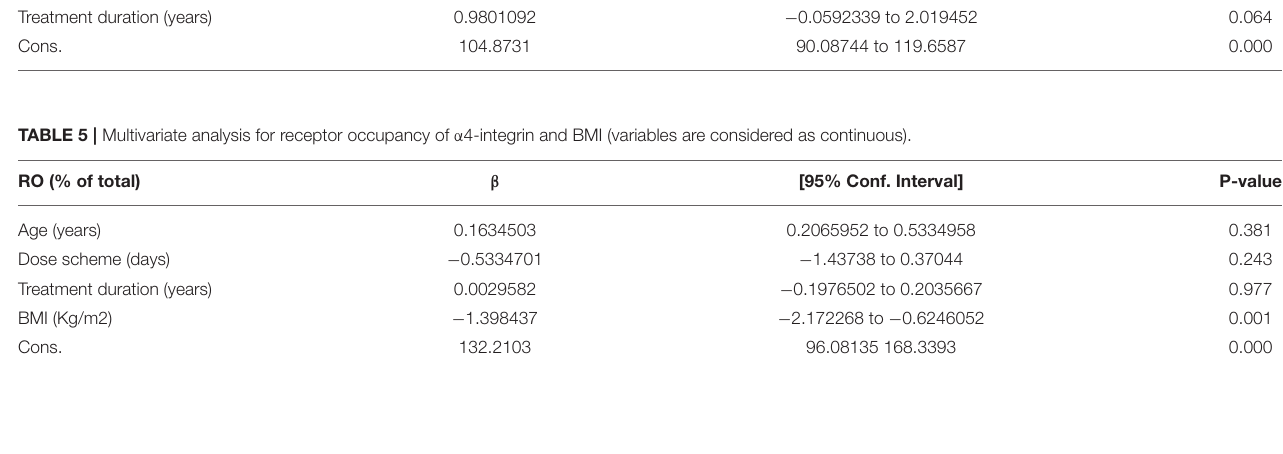
TABLE 4 | Multivariate analysis for receptor occupancy of α 4-integrin and body weight (variables are considered as continuous). RO (% of total) β [95% Conf. Interval] P-value Weight (Kg) − 0.3124683 − 0.4981626 to − 0.126774 0.001 Treatment duration (years) 0.9801092 − 0.0592339 to 2.019452 Cons.